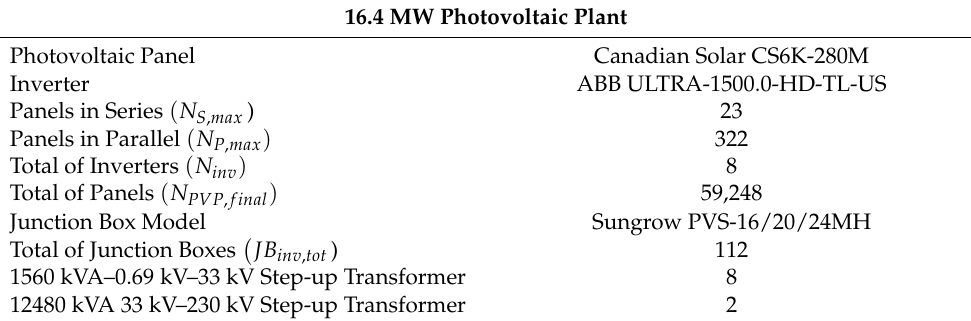
Table 1. Equipment and components of the photovoltaic solar generation system.